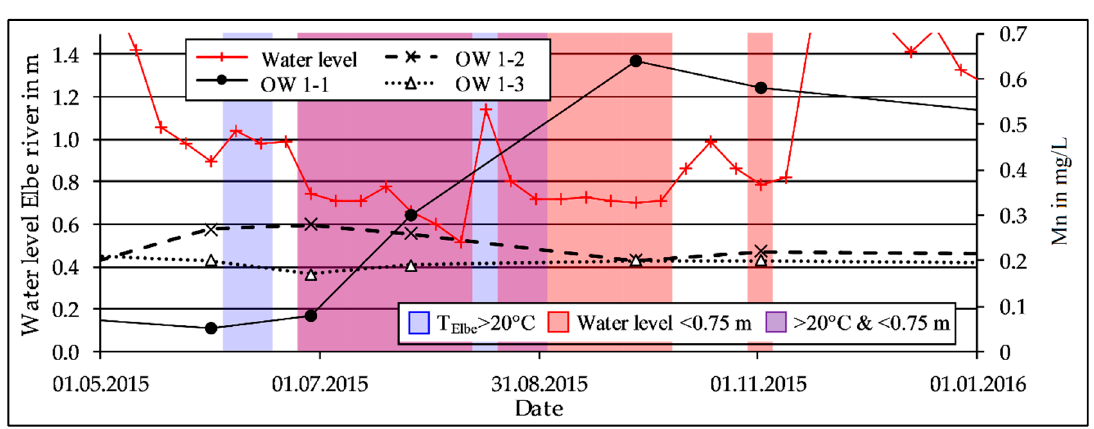
Figure 4. The Mn concentration at OW 1 during a low discharge period in 2015.